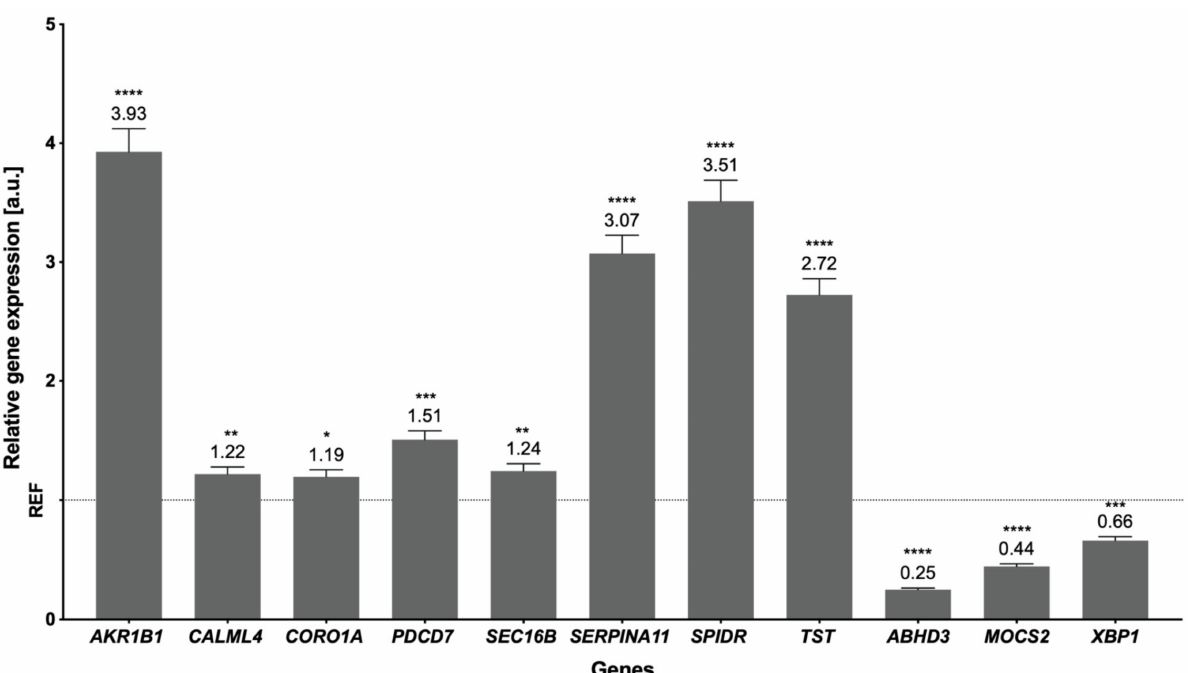
Figure 5. The mRNA expression of selected genes obtained through real-time PCR. The expression of endogenous control is shown as normalized to a value of 1 (REF), and the expression of vali- dated genes indicates the changes relative to the control. The exact values of the expression are marked above the bars. P values ≤ 0.05 were considered statistically significant where ≤ 0.0332 (*), ≤ 0.0021 (**), ≤ 0.0002 (***), and ≤ 0.0001